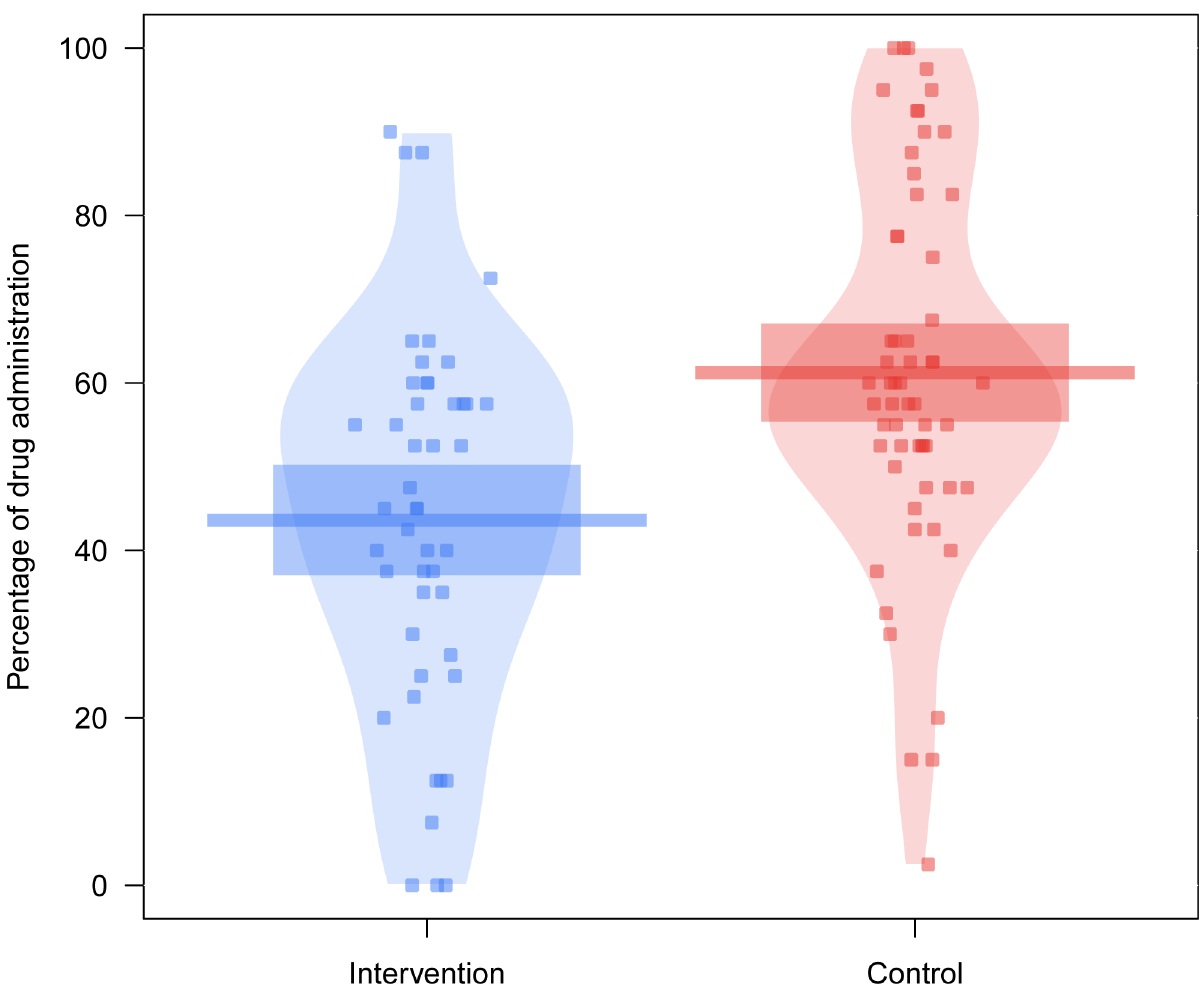
Fig 2. Percentages of drug administration. For each condition, the points represent the raw data, the horizontal lines represent the mean percentage of drug administration, and the rectangles the 95% confidence